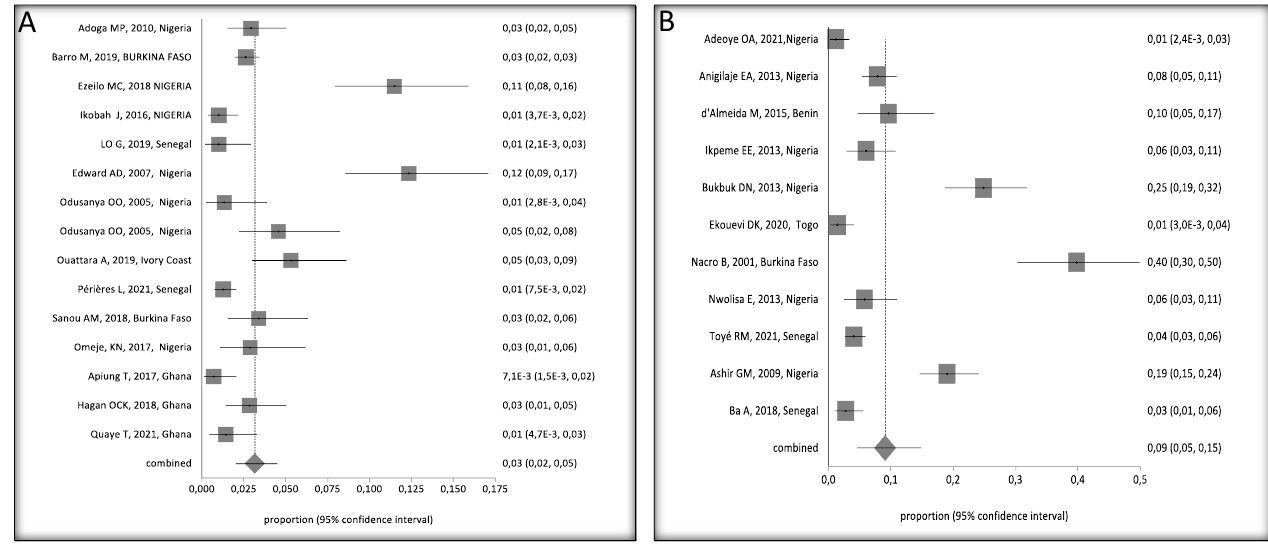
Figure 5. Forest Plots of HBV Prevalence in Children 0 – 16 Years Old in West Africa, ( A ) Without Risk Factors and ( B ) With Risk Factors [24 – 34,36 – 41,43 – 45,47 – 50]. A black square represents the HBV prevalence in the forest plot. The square position represents the prevalence in each study in the meta-analysis.